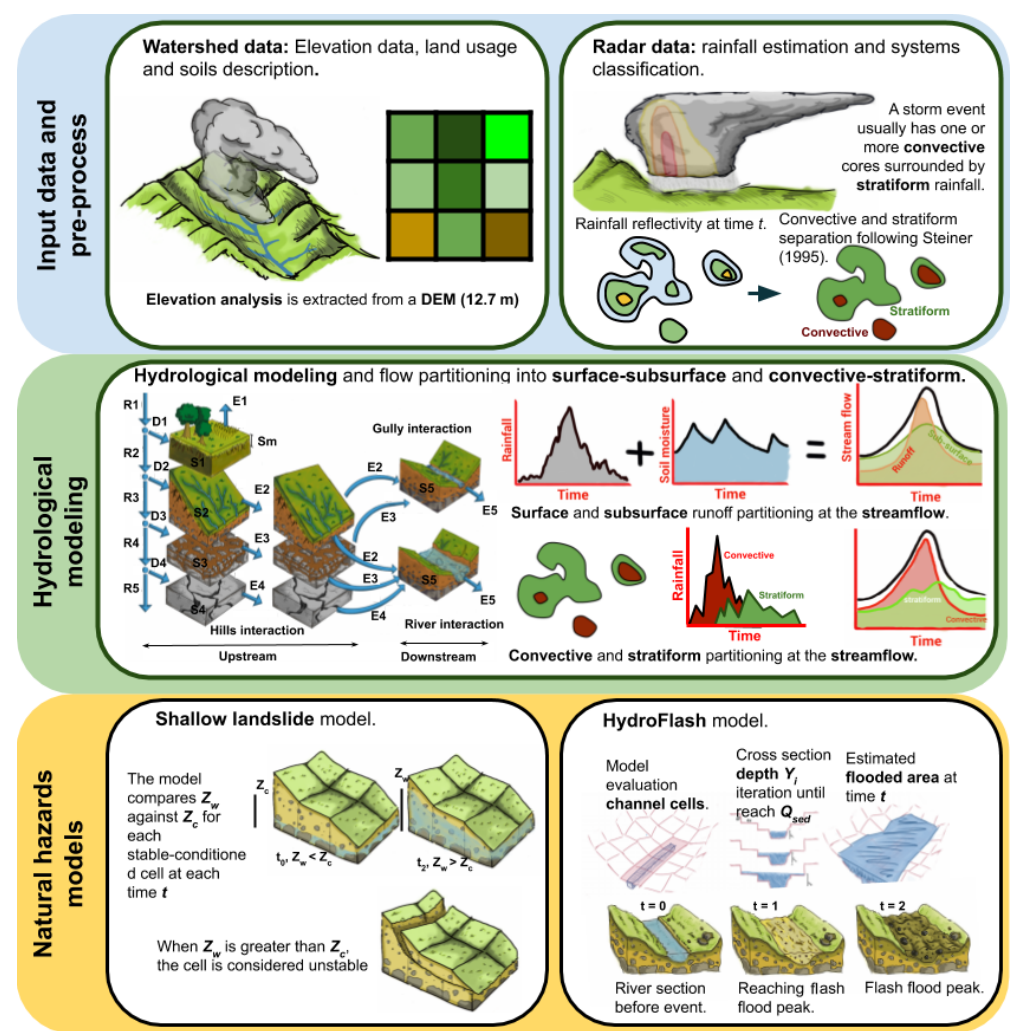
Figure 6. Illustrative diagram of the methodology followed in the present study. The top row represents the key input data, specifically a DEM and radar-based QPE as the basis of the modeling framework. The second row represents the conceptual basis of the TETIS model. In each cell, five tanks represent the hydrological processes, including capillary (tank 1), gravitational (tank 2), runoff (tank 3), baseflow (tank 4) and channel storage (tank 5). The state of each tank varies as a function of vertical and lateral flows as shown in the diagram, where the storage is represented by S i and the vertical input by D i , which in turns depends on the vertical flow through tanks R i . E i represents the downstream connection between cells and evaporation. The implementation of convective and stratiform rainfall separation and virtual tracers is also portrayed. The implementations of the landslide and HydroFlash submodels are schematized in the bottom